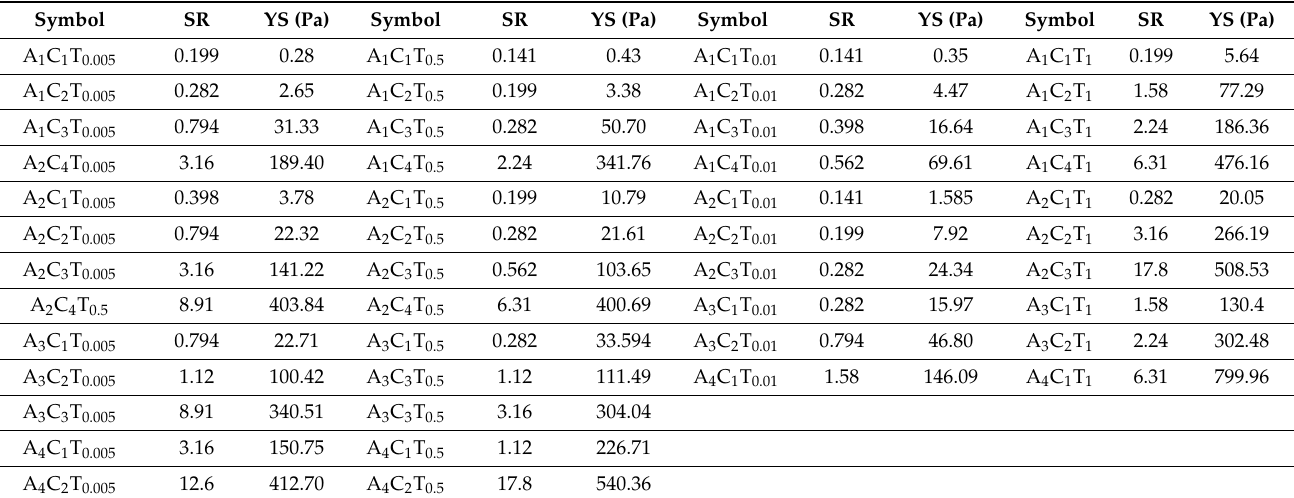
Figure 8. Shear stress of compositions prepared by ( a ) 0.01%, ( b ) 1.0%, ( c ) 0.005%, and ( d ) 0.5% TO-NFC. These results also showed a shear thinning behavior where the shear stress was increased with increasing the shear rate. It basically followed the Herschel–Bulkley equation [40], τ = τ 0 + K where τ 0 is yield stress [41] and τ is dynamic shear stress with respect to the shear rate. Table 3. Yield stress ( τ 0 ) and corresponding shear rate ( of alginate (1, 2, 3, and 4%, w / v ), CMC (1, 2, 3, and 4%, w / v ), and TO-NFC (0.005%, 0.01%, 0.5%, and 1.0% w / v